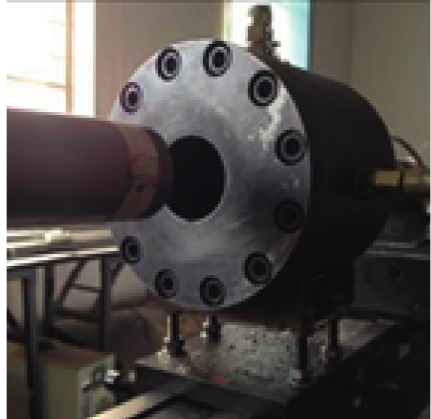
Figure 2: Device for active confining pressure